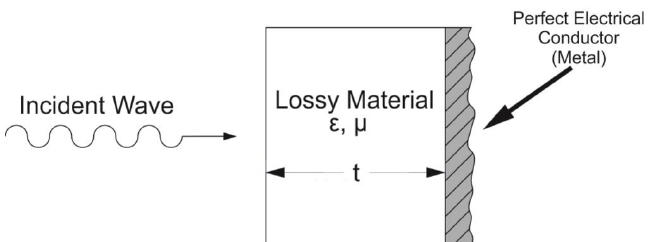
Figure 2. Schematic of the Rozanov configuration: the metallic plane (perfect electrical conductor) reflects the wave transmitted in the lossy slab (white)